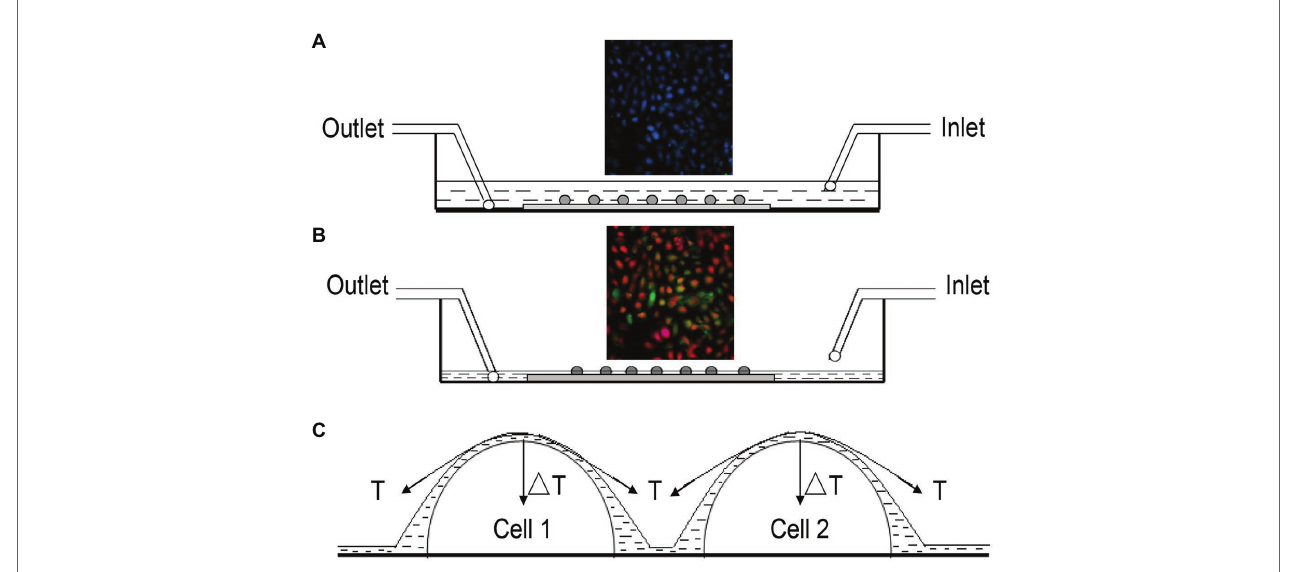
FIGURE 1 | Illustration of approach to produce the air-liquid interface (ALI) on urothelial cells. (A) Cross-sectional view of the flow chamber continuously perfused with Hank’s balanced salt solution (HBSS), for which influx was driven by gravity and efflux was driven by a vacuum pump. Monolayer urothelial cells were immersed in HBSS, and no ALI was formed when influx and efflux were balanced. Fluorescence signals at 340 or 380 nm were monitored simultaneously, and signals showed no change (inset). (B) To produce the ALI, influx was stopped but efflux was continued. Once the amount of HBSS solution in the chamber was reduced to a specific level at which a thin liquid film was formed on the cells, they were mechanically deformed by the tension force at the ALI, which altered the fluorescence signals (inset). The above process usually took about 10–15 s. Perfusion was resumed immediately after noticing a change in fluorescence signals. (C) Simplified situation of two hemispherical cells covered by a thin liquid film, where T is the surface tension of the liquid and Δ T is the net component of T, acting perpendicularly to the cell surface to cause cell